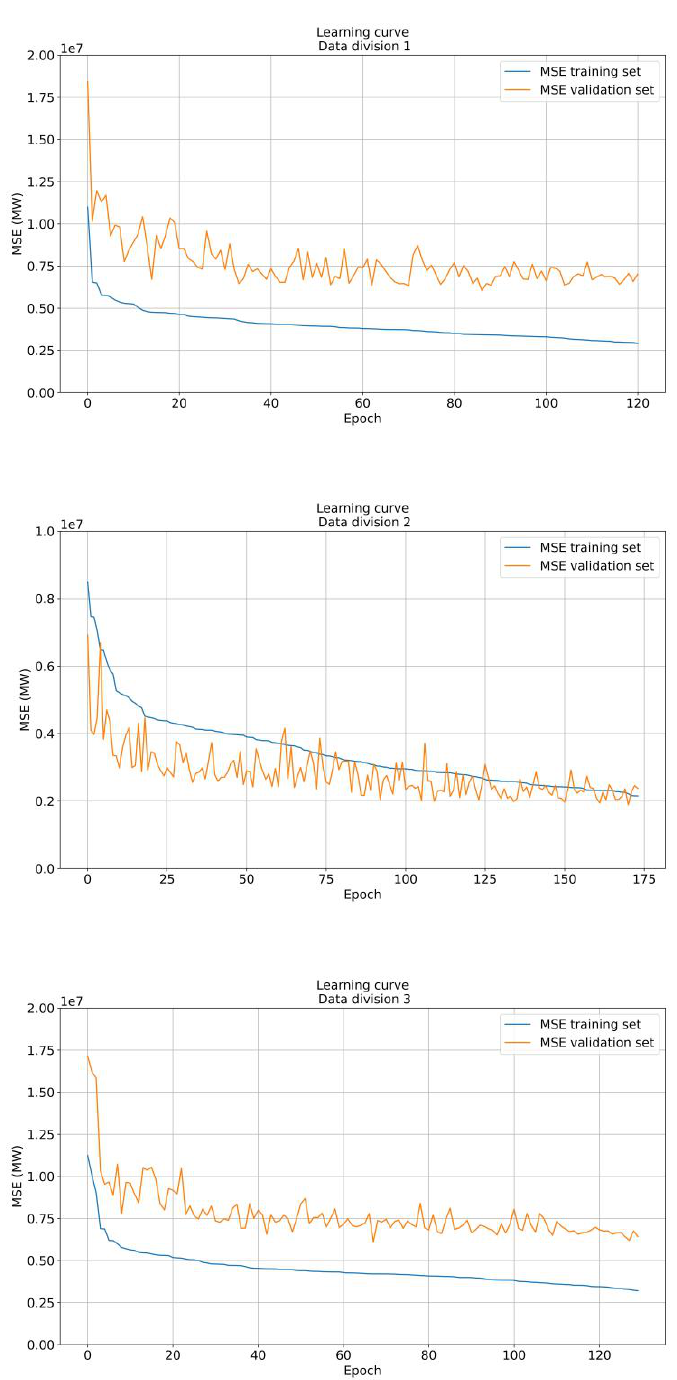
Figure 7. Learning curves for each data division.